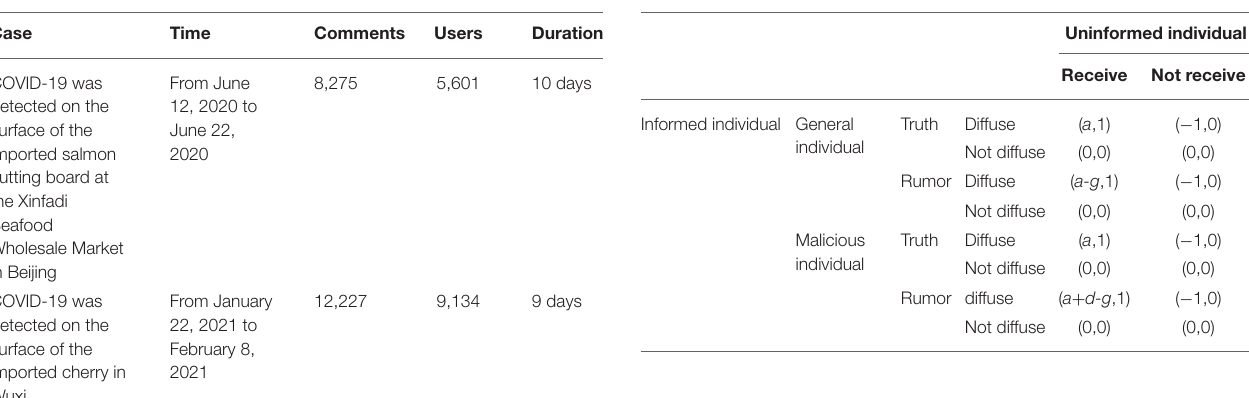
TABLE 4 | Relevant data. TABLE 5 | Gain matrix of the evolutionary game